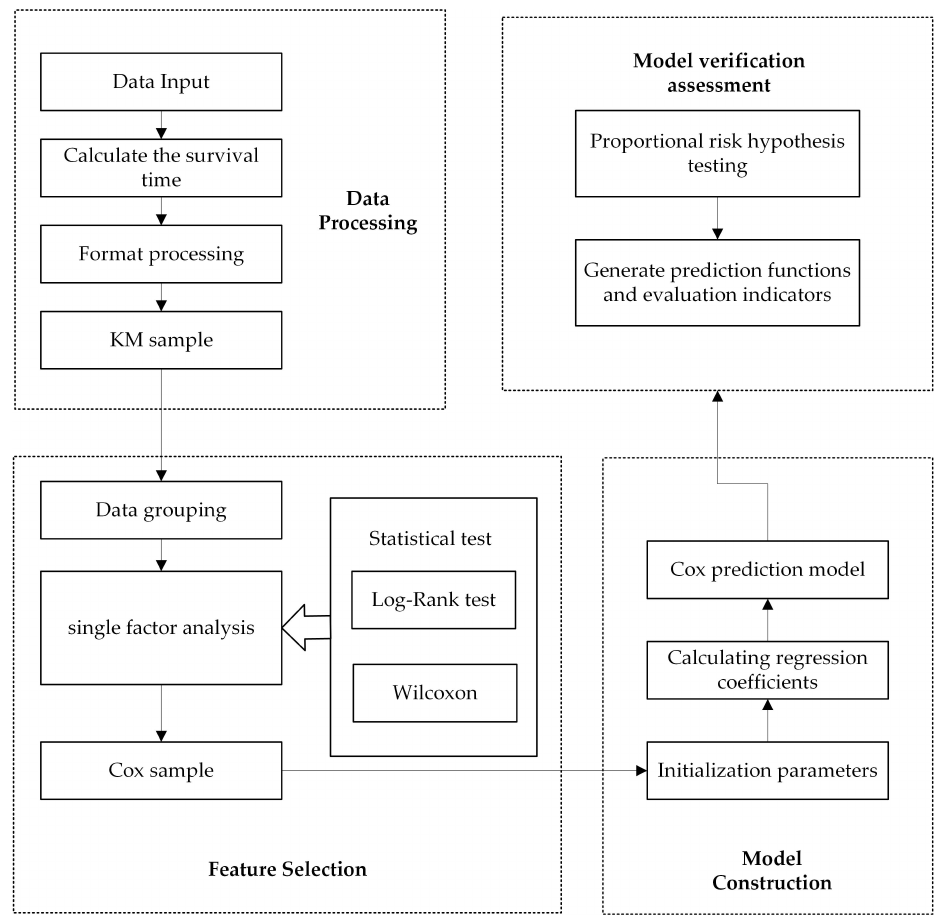
Figure 2. Cox-CSDPC disease prediction model